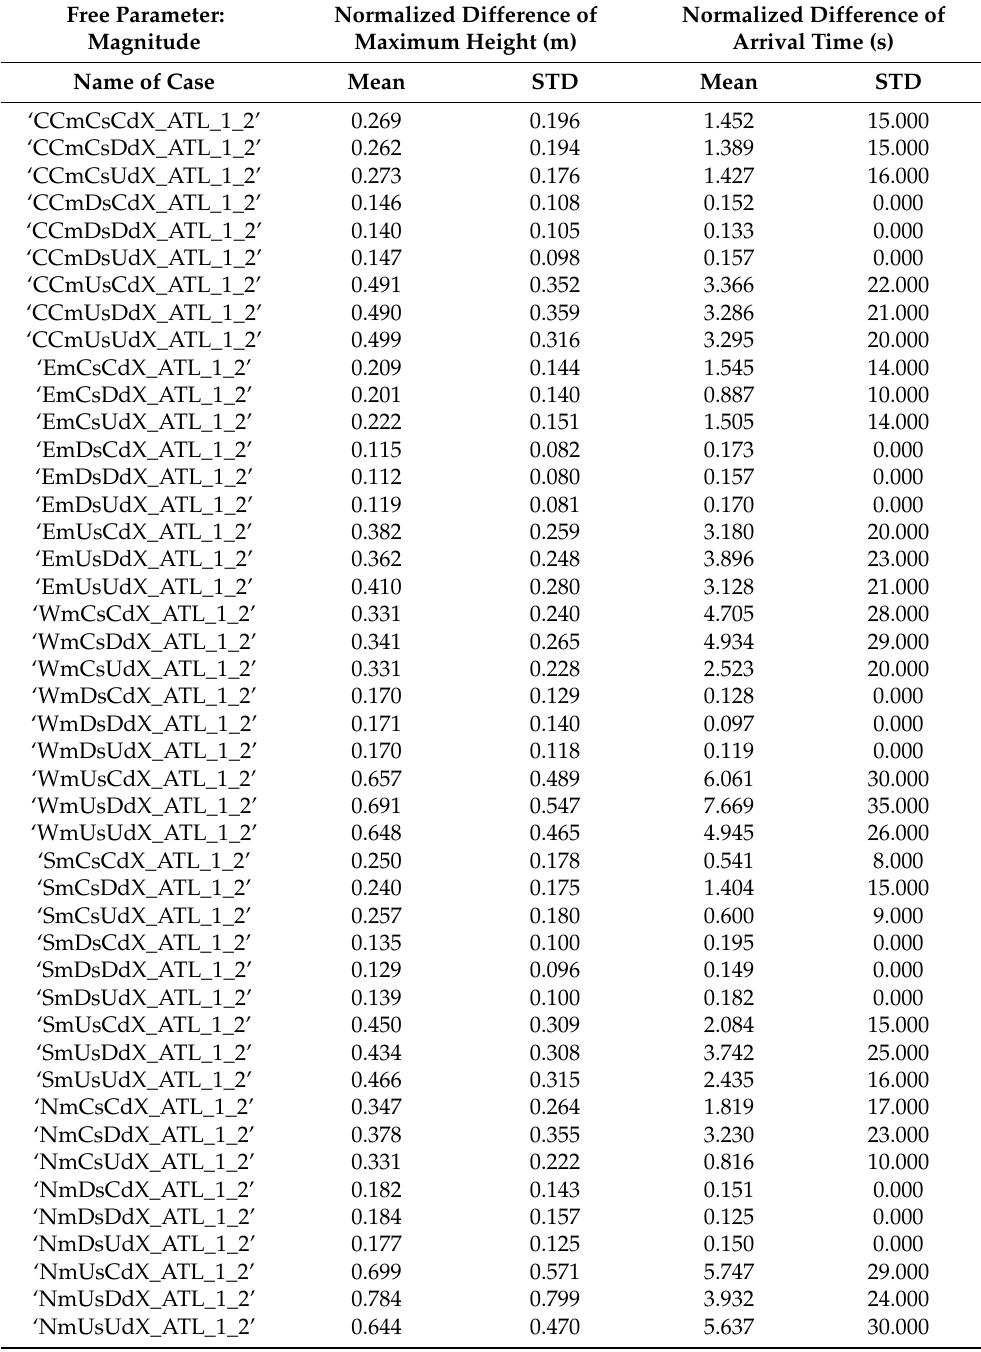
Table A3. Mean normalized difference of maximum height and of arrival time for scenarios with varying